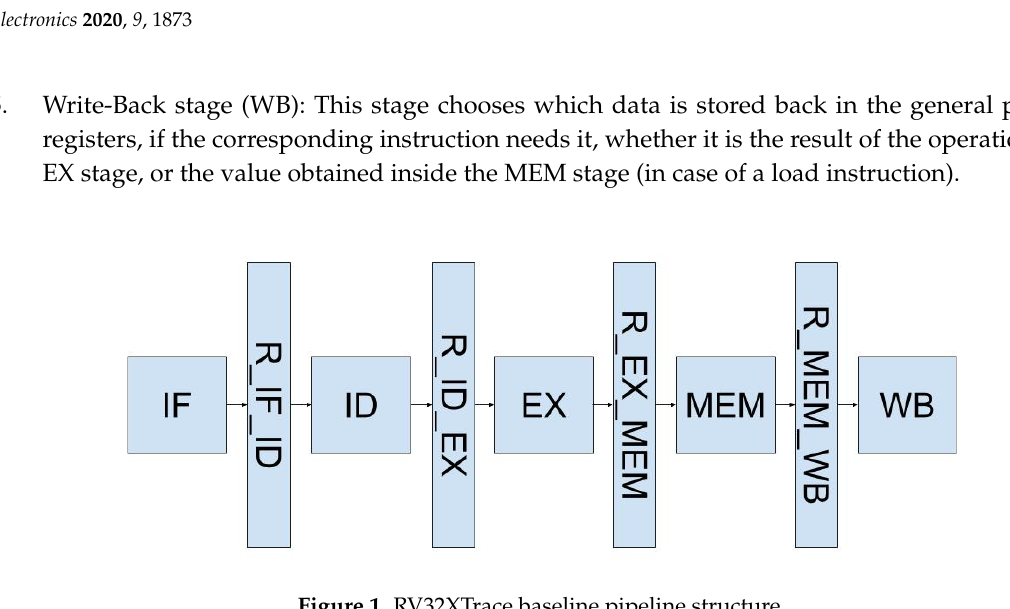
Figure 1. RV32XTrace baseline pipeline